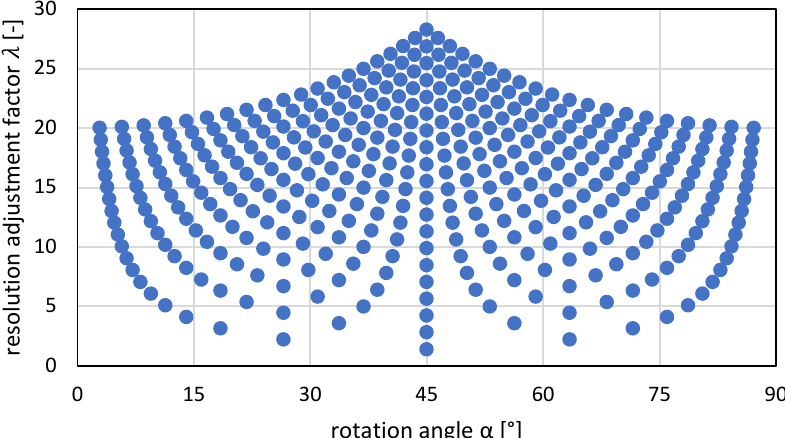
Figure 7. Association of the rotation angles as well as resolution adjustment factor for u – v grids with 1 ≤ u , v ≤ 20